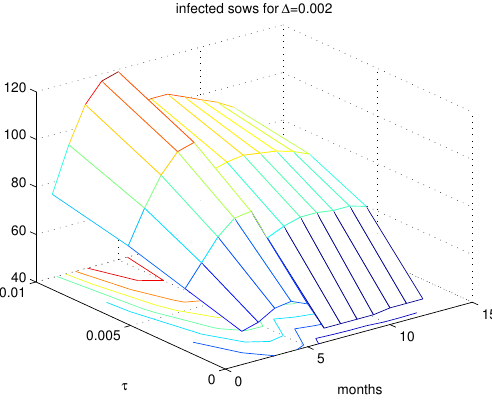
Fig. 8 Infected sows evolution during a whole year. Here we fix the value of biohazard rate at ∆ = 0 . 002.